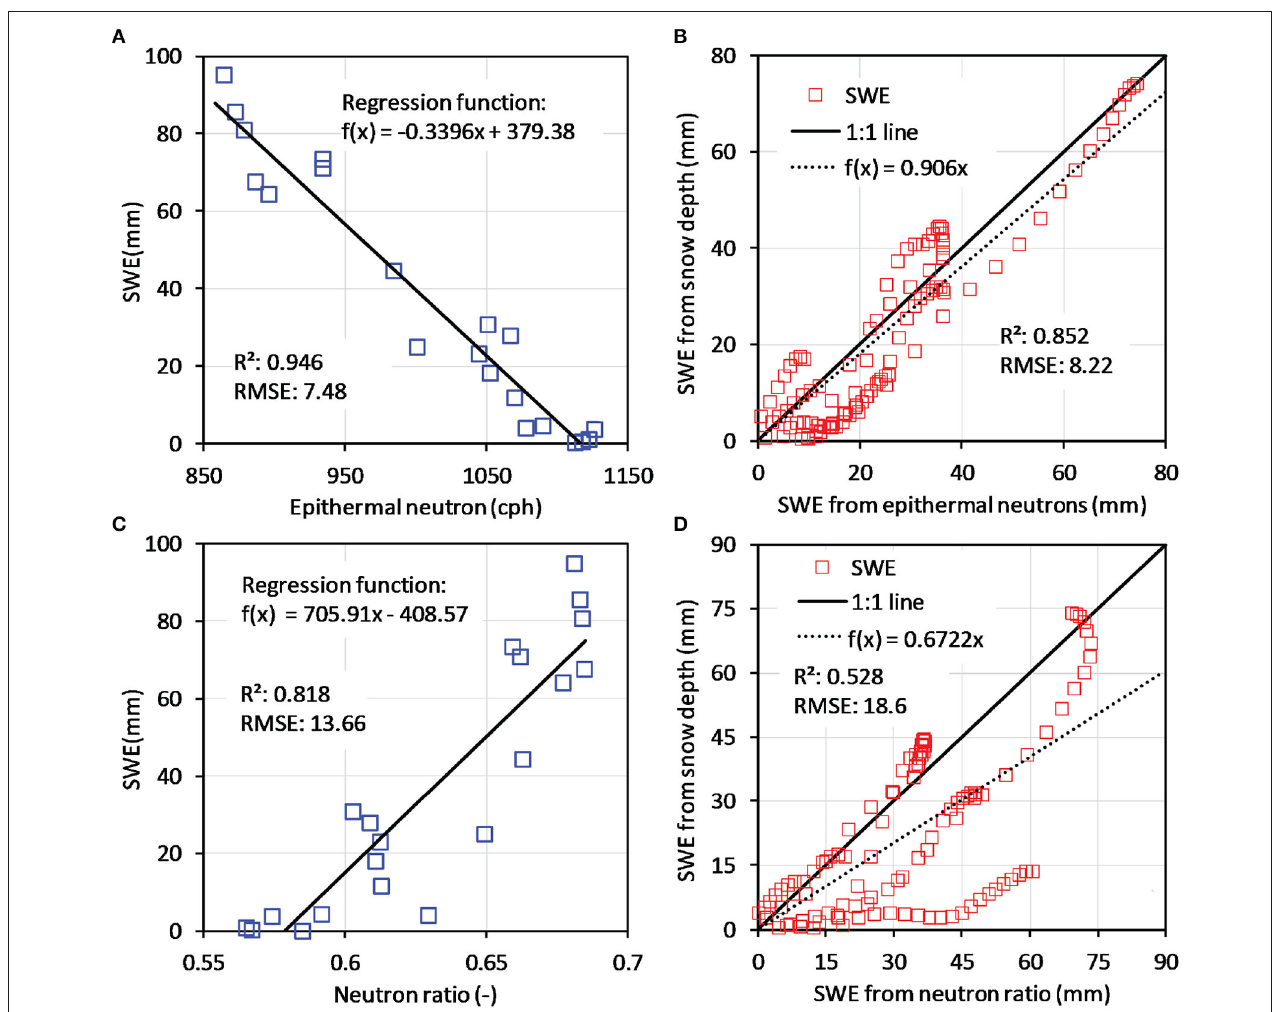
FIGURE 7 | (A) Relationship between SWE derived from 20 snow depth measurements (also shown in Figure 6 ) and corresponding epithermal neutron measurements; (B) validation of regression function to obtain SWE from epithermal neutron intensity using SWE from all snow depth measurements; (C) relationship between SWE derived from 20 snow depths and corresponding neutron ratios; (D) validation of regression function to obtain SWE from neutron ratio using SWE from all snow depth